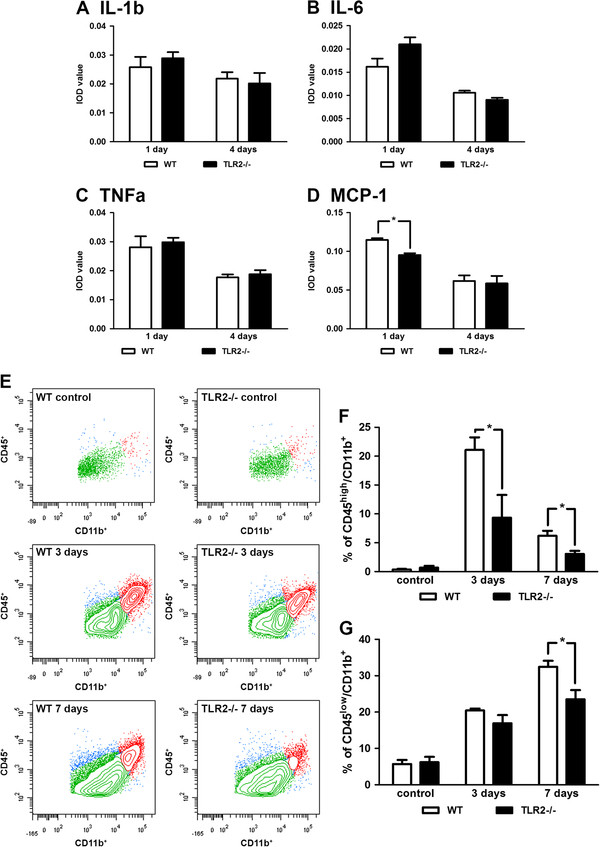
Decreased levels of MCP-1 and CD45high/CD11b+expressing cells in Toll-like receptor 2 deficient mice. (A-C) Expression analysis of inflammatory cytokines IL-1β, IL-6 and TNF-α on protein levels 1 and 4 days after transient middle cerebral artery occlusion (MCAO) revealed no significant difference between wild-type (WT) and Toll-like receptor (TLR) 2−/− groups. (D) Significant reduction of MCP-1 levels in the TLR2−/− group compared with their WT controls 1 day after transient MCAO. (E) Topographic representation of isolated brain mononuclear cells from ischemic hemispheres of control, WT and TLR2−/− mice 3 and 7 days after stroke, analyzed using two-color flow cytometry. Cells were analyzed for CD45 and CD11b, thus allowing us to distinguish two different cell populations: CD45high/CD11b+ (that is, the macrophage-like) population (red); and CD45low/CD11b+ (microglial) population (green). (F) Flow cytometric analysis showed a significant decrease in the number of CD45high/CD11b+ cells in TLR2−/− mice compared with WT mice at both 3 and 7 days after stroke. (G) Quantitative analysis of CD45low/CD11b+ cells (microglia) indicates a significant reduction in cell numbers in TLR2−/− mice as compared with WT 7 days after stroke, while 3 days after stroke the difference is not significant, but there is a tendency toward reduced cell numbers in TLR2−/− mice. Values (A-D) are expressed as mean ± SEM (n = 4, *P <0.05). Data (F, G) are expressed as percentage of CD45+ events ± SEM (n = 4; *P <0.05).